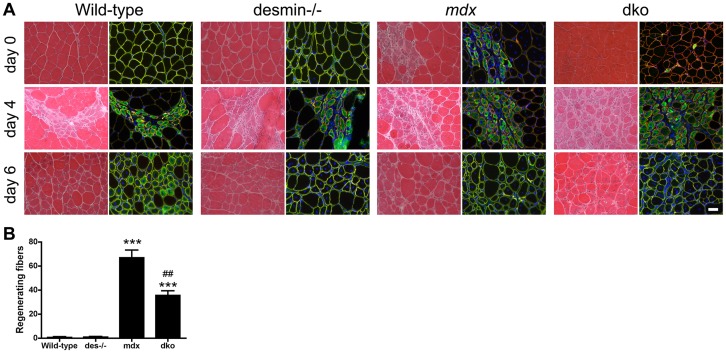
Regenerative capacity of muscle.
A) Transverse sections of uninjured (Day 0) or injured gastrocnemius muscles 4 days and 6 days post notexin administration. Sections stained with hematoxylin and eosin are shown in the left columns and developmental myosin heavy chain (green), α2-laminin (red) and DAPI (blue) are shown in the right columns. Scale bar  = 50 µm. B) Bars represent the mean +/− S.D. of the total number of regenerating fibers in the uninjured gastrocnemius muscles (Day 0). ***P<0.001 compared with wild-type muscles and ##
P<0.01 compared with mdx4cv muscles. N = 4 mice for all experiments.